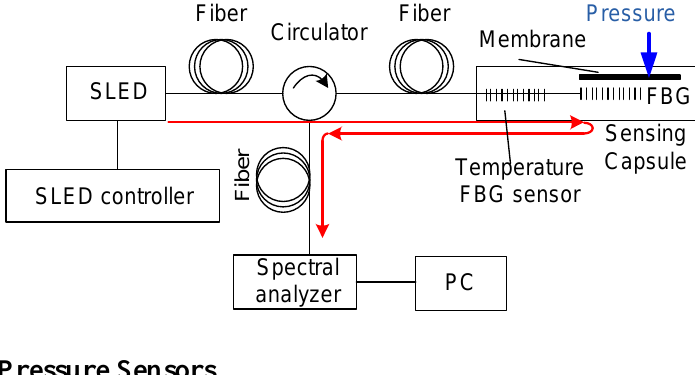
Figure 3. Complete measurement setup with super luminescent diode as the source of optical signals, optical path components and spectral analyzer for evaluation of reflected optical signals from the sensing FBG. The red line shows the optical signal trace and the blue arrow the direction of an applied pressure.